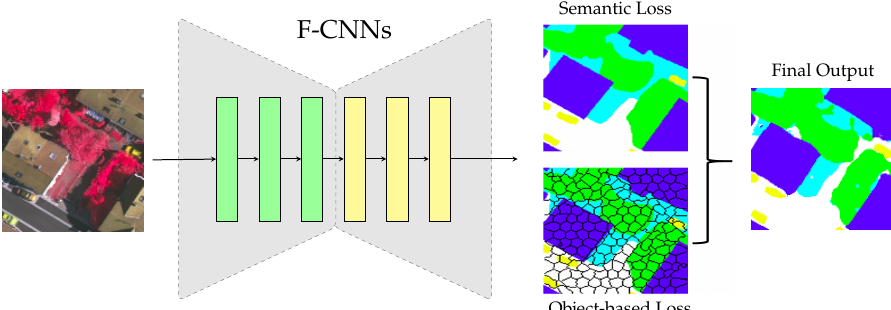
Figure 1. Illustration of the proposed object-based deep learning framework. The input image is fed to a F-CNN architecture with encoding (green) and decoding (yellow) layers. During the pixel-based optimization procedure, the semantic loss is calculated by comparing the network output with the reference data, while the object-based loss constrains the semantic labels to be the same with the dominant label inside each superpixel. The two losses are then combined together to produce the final segmentation